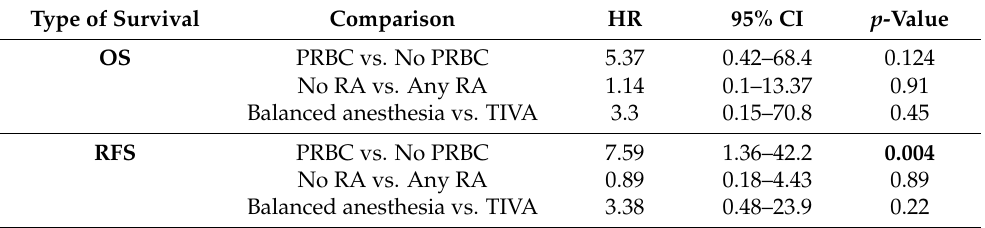
Figure 1. Kaplan-Meier estimates of ( A ) overall survival and ( B ) recurrence-free survival in pediatric patients undergoing surgery for nephroblastoma ( n = 65). Survival analysis using a log-rank test compared patients with (black line) or without (grey line) intraoperative administration of packed red blood cells (PRBC). Censored events are marked with upright ticks. P -values as annotated. Table 4. Hazard ratios. OS = overall survival; RFS = recurrence-free survival; PRBC = packed red blood cells; RA = regional anesthesia; TIVA = total intravenous anesthesia; HR = hazard ratio; CI = confidence interval. Statistically significant results are shown in bold numbers.